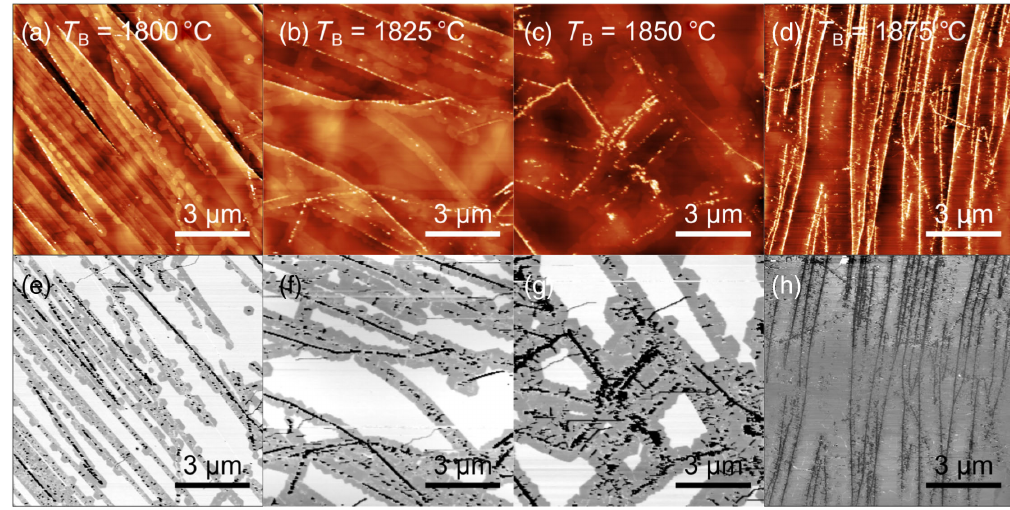
FIG. 1. Atomic force microscopy (AFM) of atomically thin h -BN grown epitaxially on highly oriented pyrolytic graphite (HOPG), for 1390 °C and a growth time of 3 h. Topography (a) – (d) and corresponding phase images (e) – (h) for boron cell a growth temperature T g ¼ 1800 , 1825, 1850, and 1875 °C. The bright areas in the phase images are HOPG regions not covered by h temperatures T B ¼